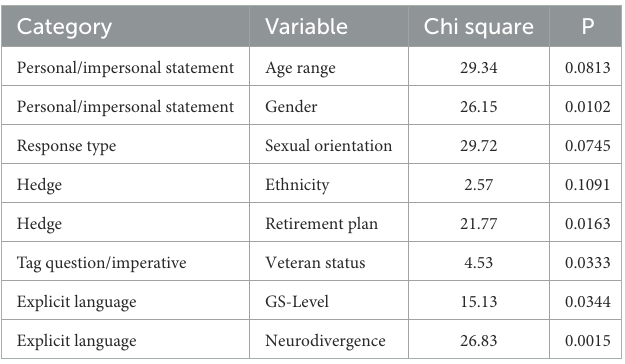
TABLE 3 Demographic and socioeconomic variables (column 2) that are significantly correlated to language use categories (column 1) using a Chi-square